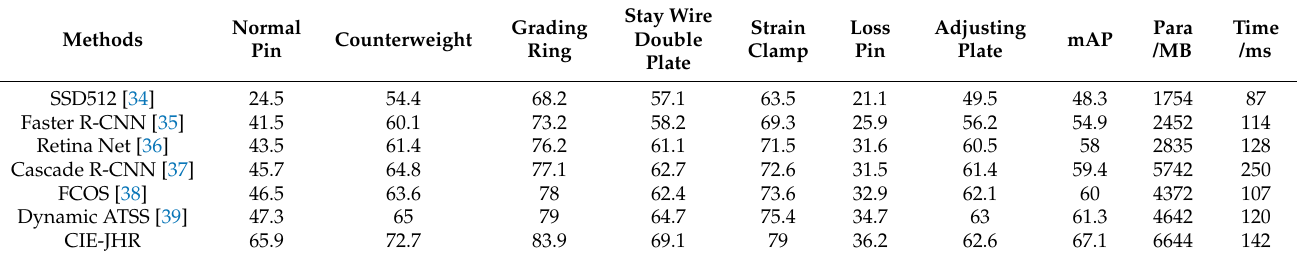
Table 5. Comparison of the detection results.